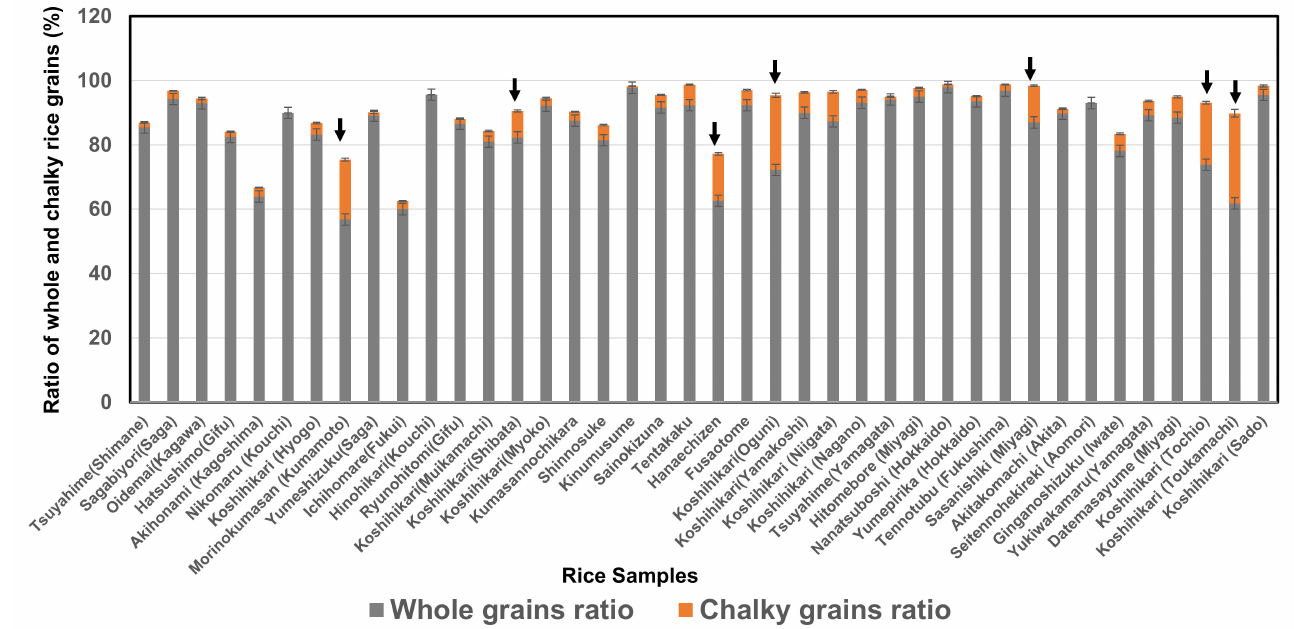
Figure 2. Ratio of whole and chalky rice grains of 40 Japonica rice samples in